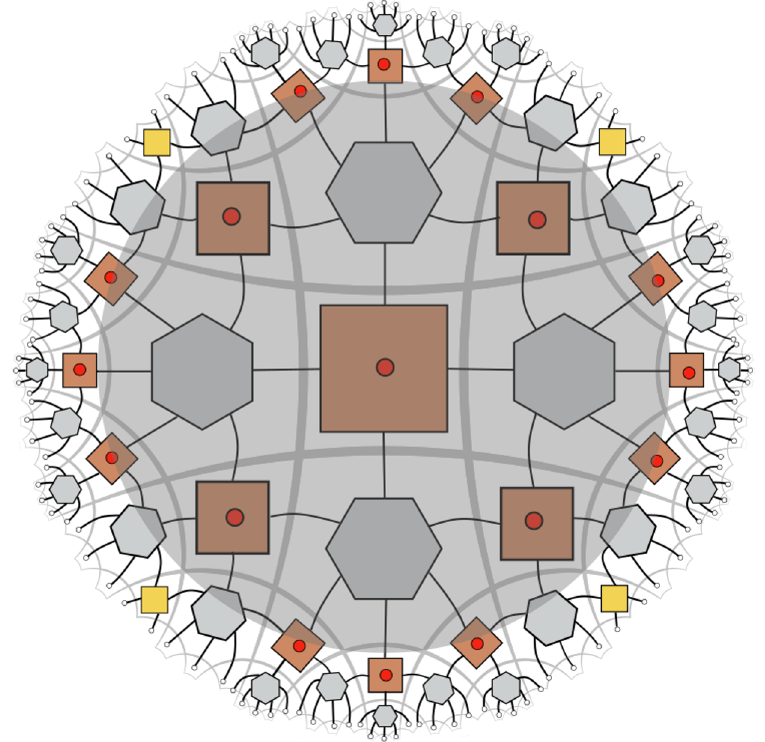
Figure 39. If the darker tiles have states in a non-zero state, then one can only access the Z subalgebras on the boundary tiles of the shaded region. Interior of the shaded region cannot be accessed exactly. All other states are in the 0 state. The central qubit is “shielded” from the boundary as it has to go through SBSTs to reach the